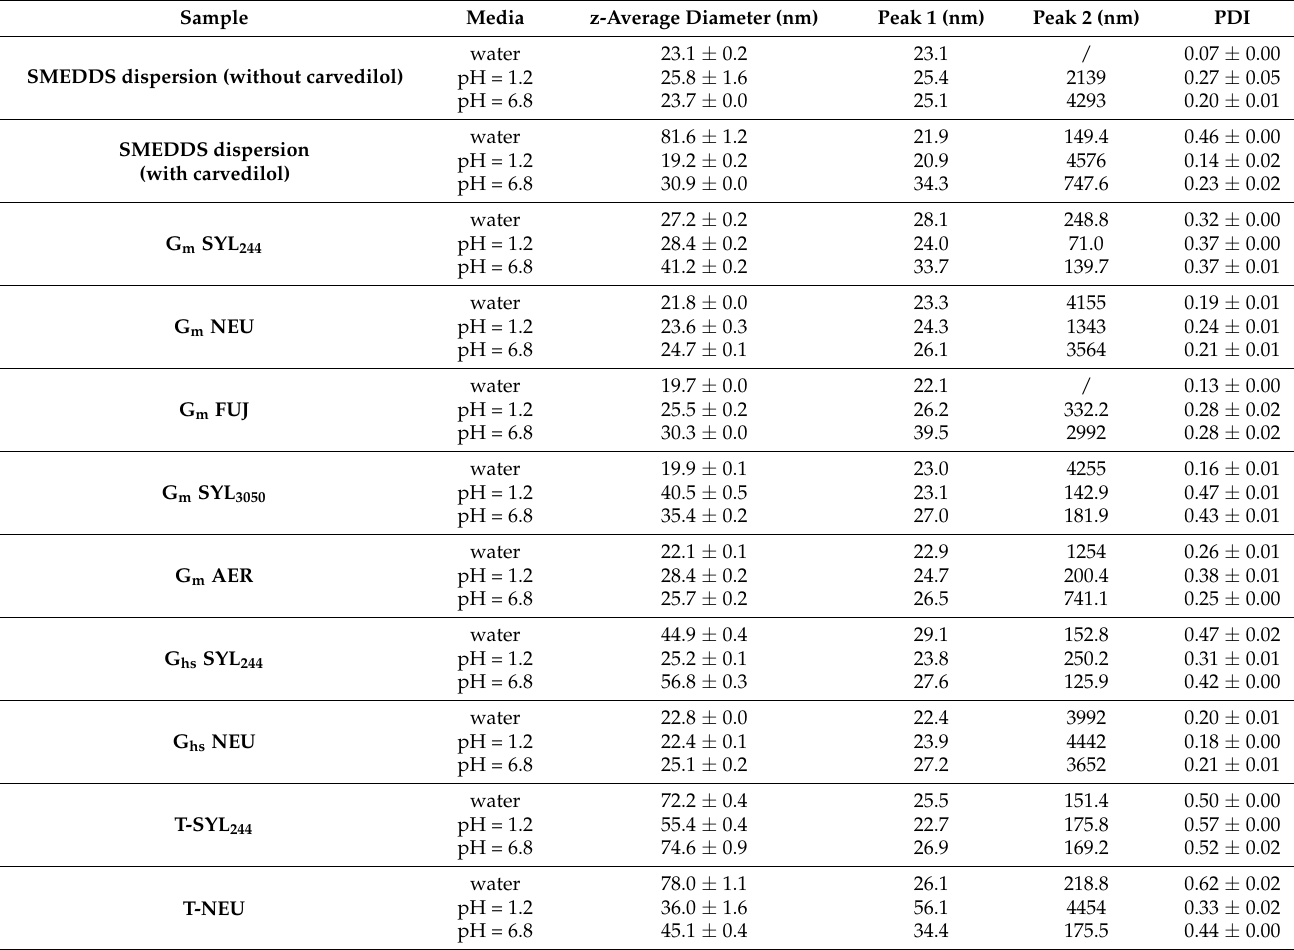
Table 5. Average droplet size (z-average diameter), individual peaks and PDI values of liquid SMEDDS, liquid carvedilol-loaded SMEDDS, granules G m SYL 244 , G m NEU, G m FUJ, G m AER, G m SYL 3050 , G hs SYL 244 and G hs NEU and tablets with G hs SYL 244 (T-SYL 244 ) and tablets with G hs NEU (T-NEU), after redispersion in three media (water, media with pH 1.2 and pH